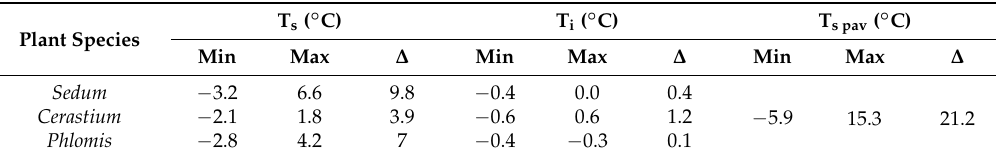
Table 10. Thermal gradients—2 February